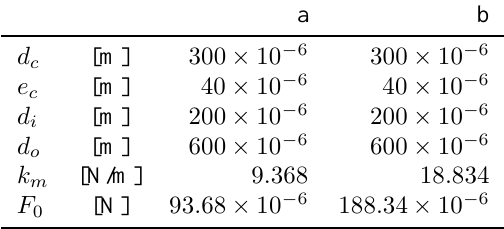
Table 1: Parameters of the various valves.